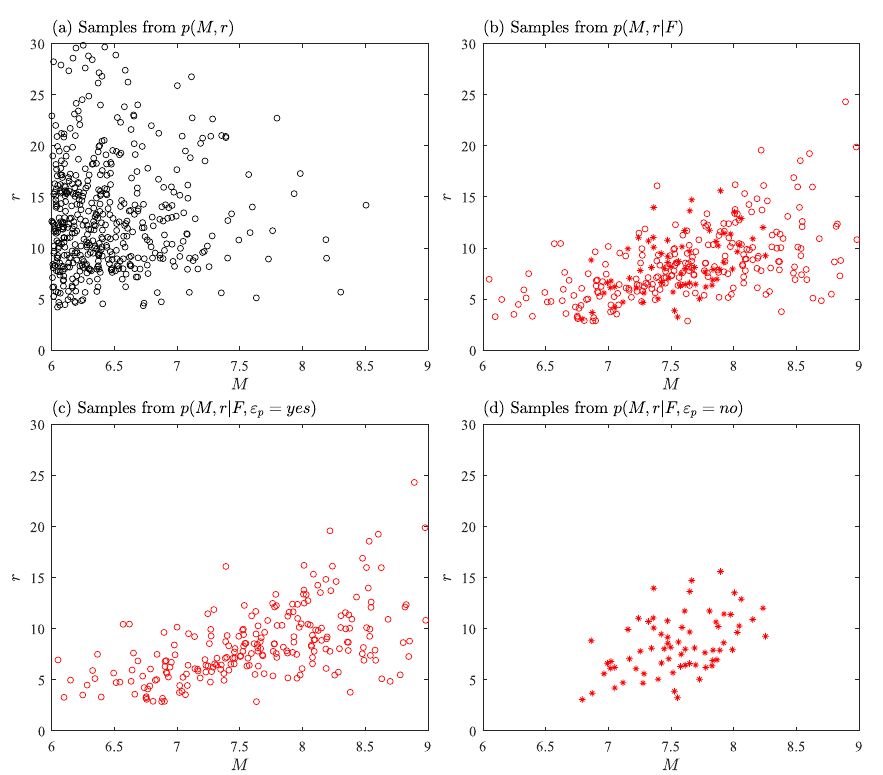
Figure 16. Samples from ( a ) p ( M , r ) , ( b ) p ( M , r | F ) , ( c ) p ( M , r | F , ε p = yes ) , and ( d ) p ( M , r | F , ε p = no ) . All plots are for cross-braced